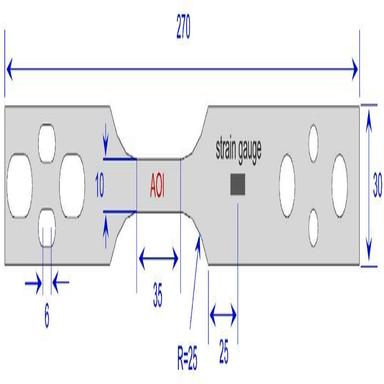
Specimen geometry for the IFHS tests (unit: mm).